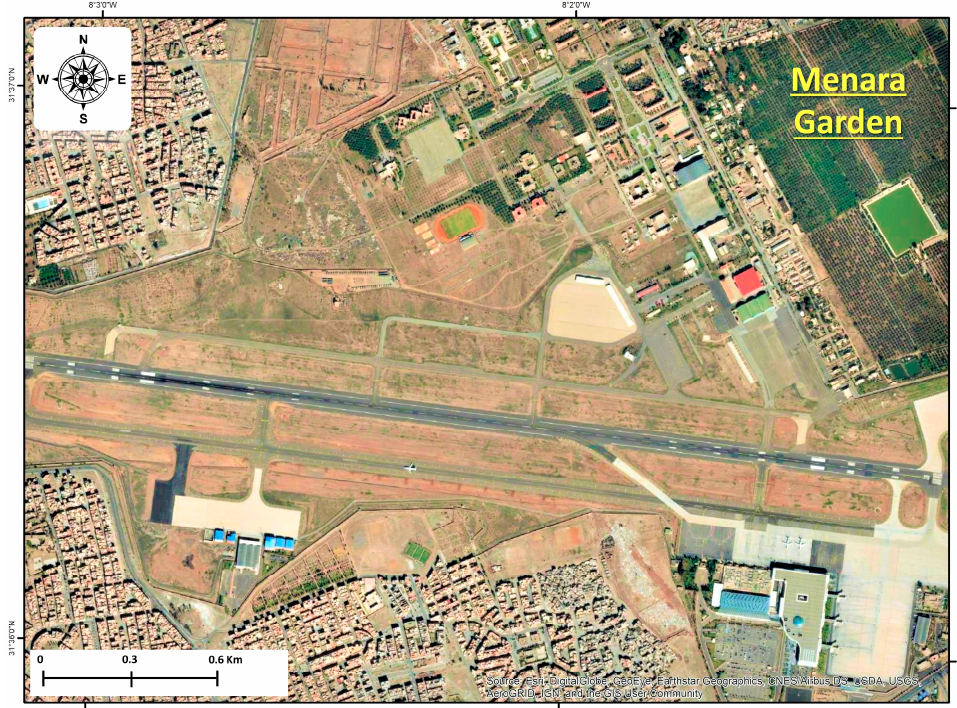
Figure 12. Neighbourhood of the Zone Airport (upper right, the Menara Garden with a water basin).